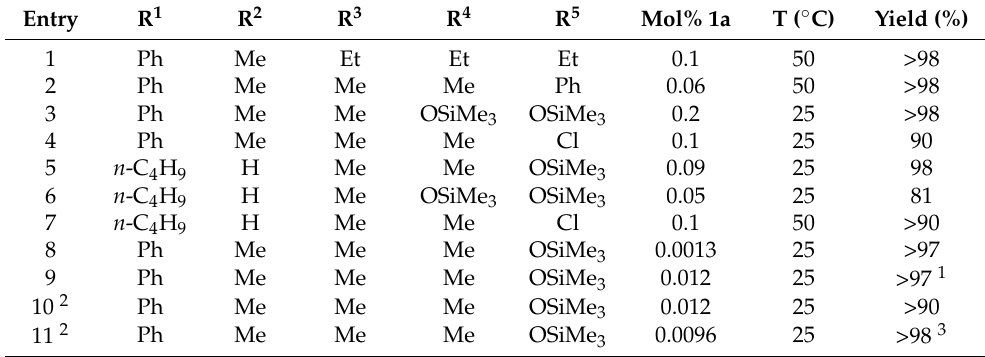
Table 3. Selected hydrosilylations [37] catalyzed by 1a in CD 2 Cl 2 .